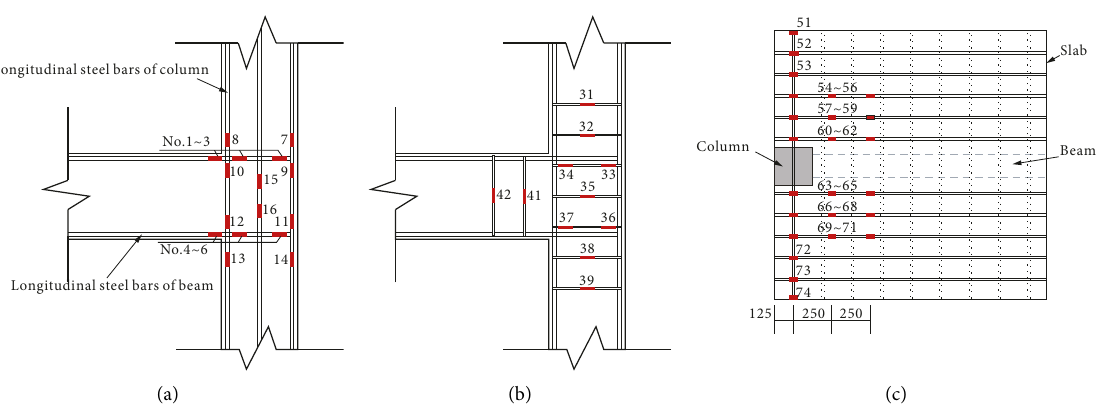
Figure 3: Arrangement of strain gauges for steel bars. (a) Strain gauges of longitudinal reinforcement. (b) Strain gauges of stirrup. (c) Strain gauges of steel reinforcement in slab.